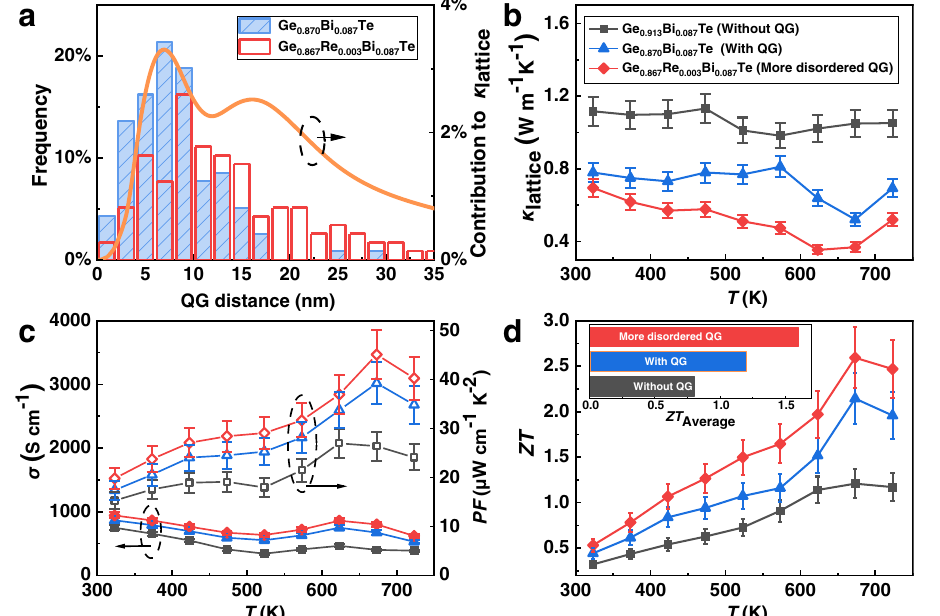
Fig. 5 | Improving the thermoelectric performance by modulating the dis- tribution of QGs. a The histogram of QGs ’ spacings and the corresponding mean- free-path resolved contribution to lattice thermal conductivity. b The lattice